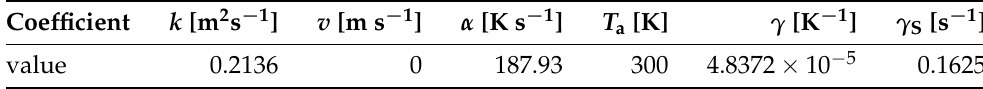
Table 2. Values for the fixed wildland fire model coefficients.